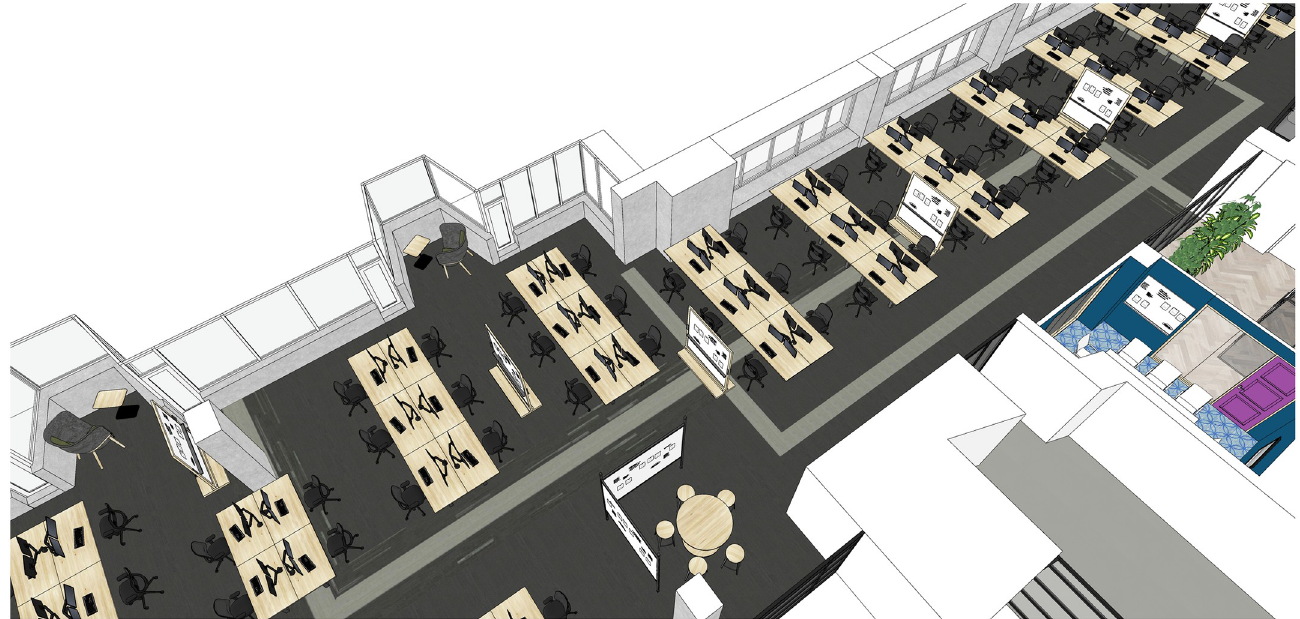
Fig 3. Open-plan (Control). Digital render of the Open-plan Control